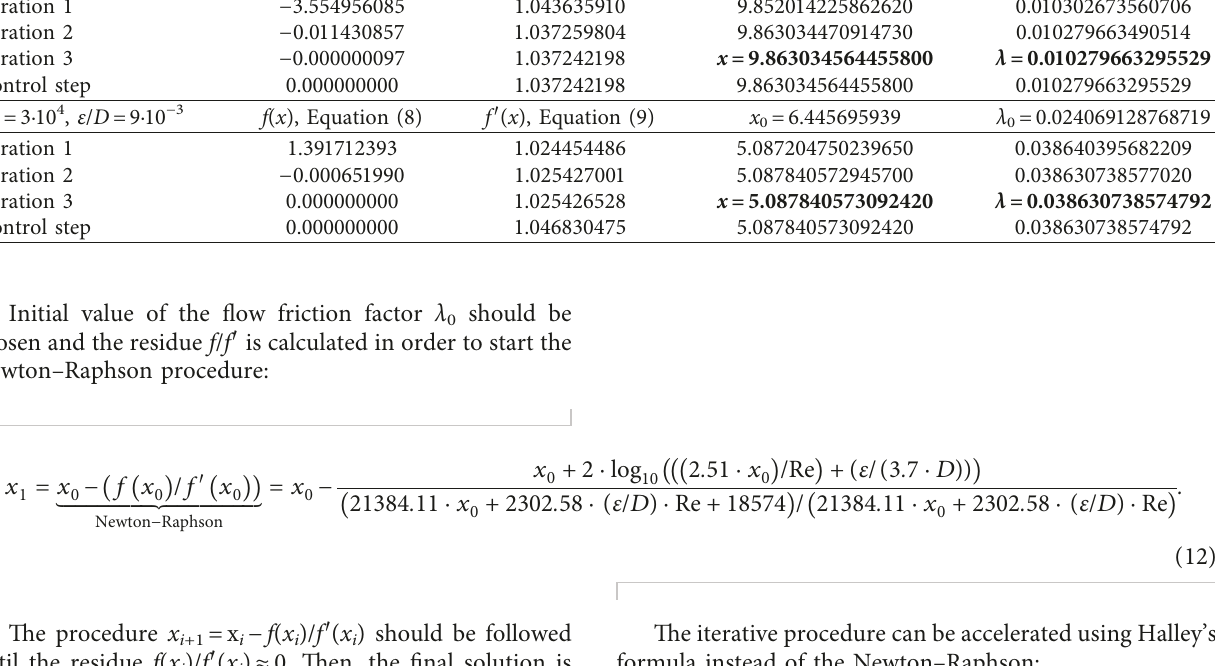
� 6.445695939 → λ � 0.024069128765101 from Section 2.2.1, 0 0